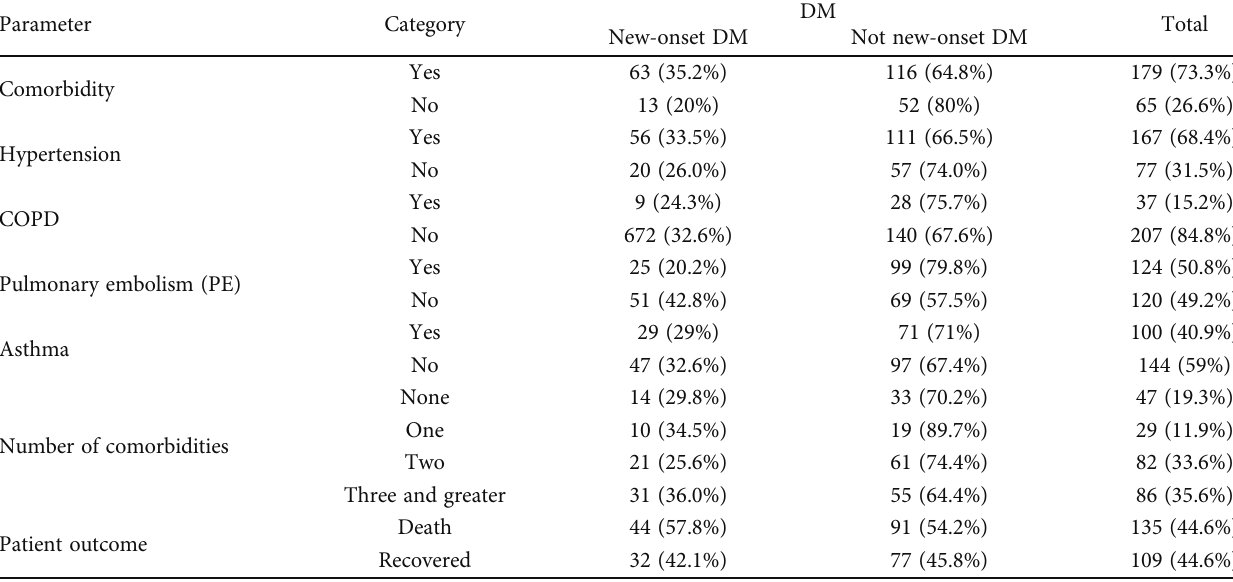
Table 4: Summaries on comorbidities of research participants at COVID-19 care center, Addis Ababa, Ethiopia, 2022 ( N = 244 ).